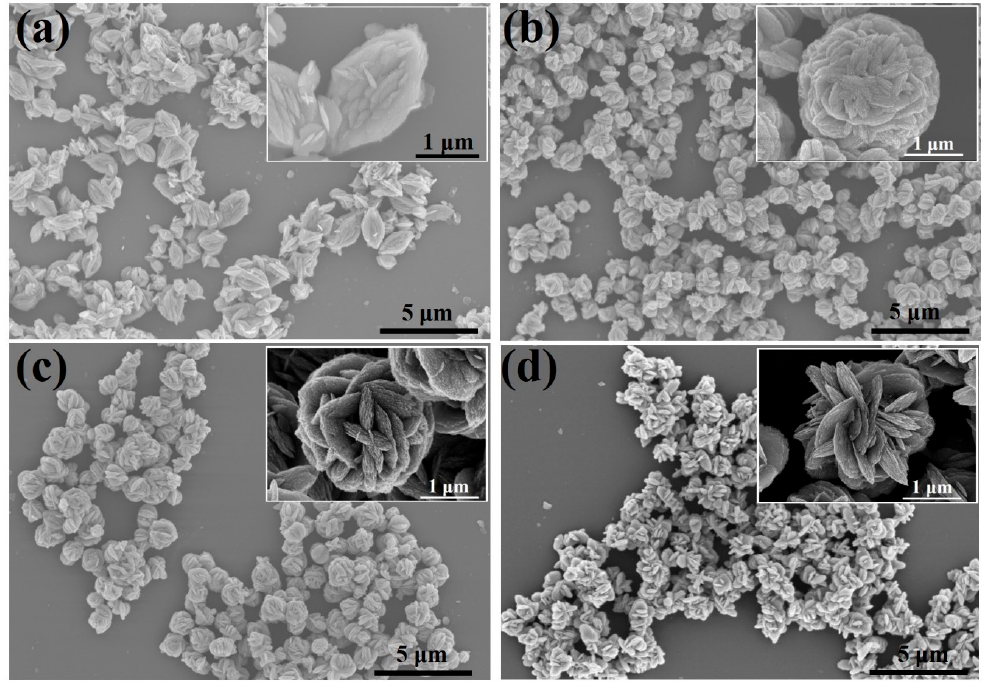
Figure 3. Field emission scanning electron microscope (FESEM)images of ( a ) 0.00Pt-CuO, ( b ) 0.75Pt-CuO, ( c ) 1.25Pt-CuO, and ( d ) 1.50Pt-CuO. The inset is the magnification of each image.